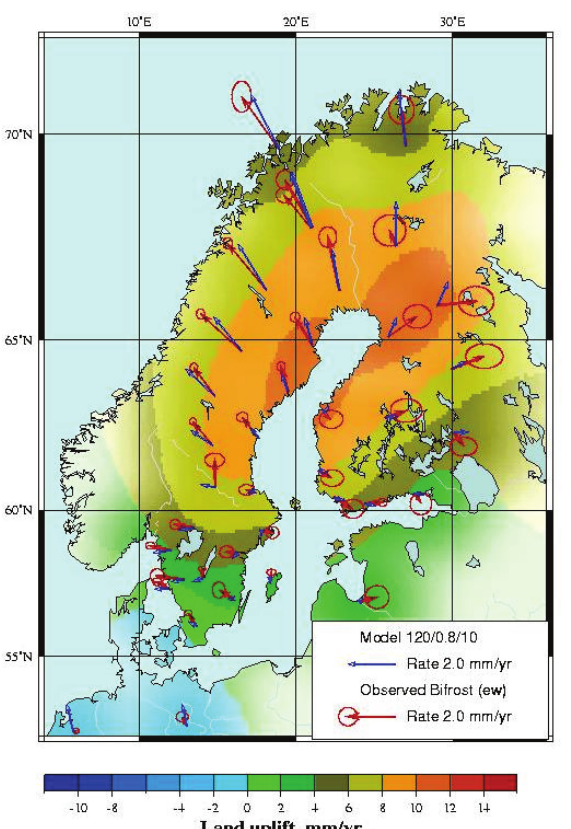
Fig. 1. BIFROST land uplift model (2001) (johansson et al. 2002)